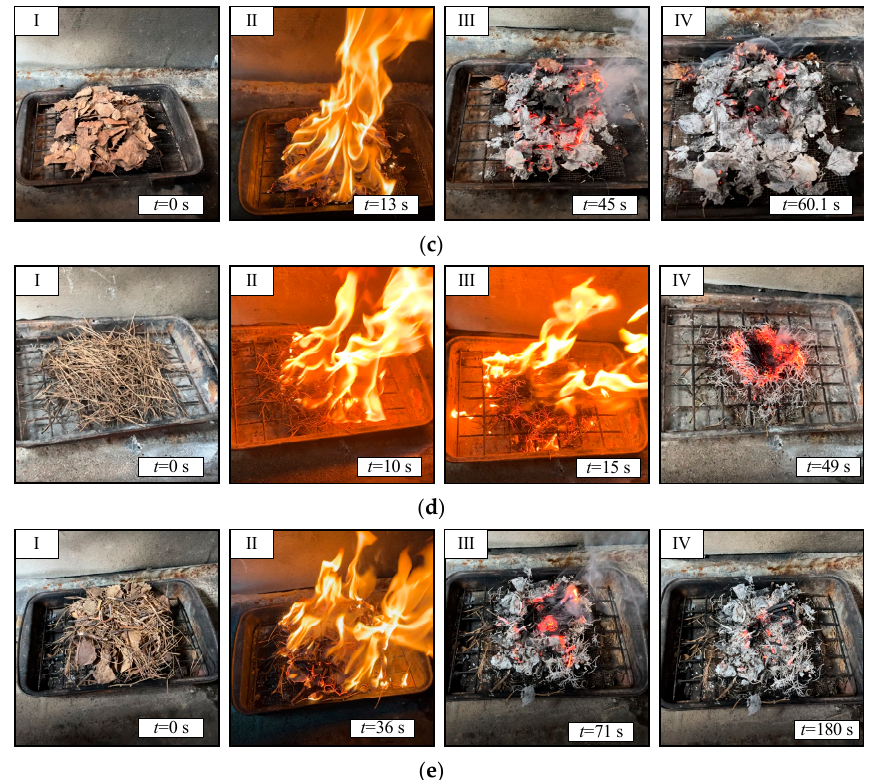
Figure 2. Images of laboratory-scale fires at different combustion stages: I—combustible material sample at the initial point (before ignition); II—active combustion; and III—decay and smoldering; IV—release of combustion products stops. ( a )—branches; ( b )—timber; ( c )—leaves; ( d )—needles; and ( e )—mixture of forest fuels.